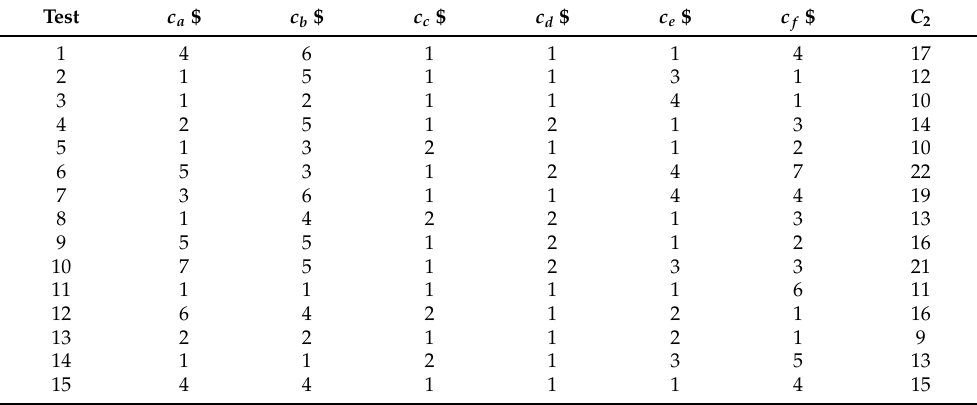
Table A4. Costs for fermentation-based extraction method ( i =